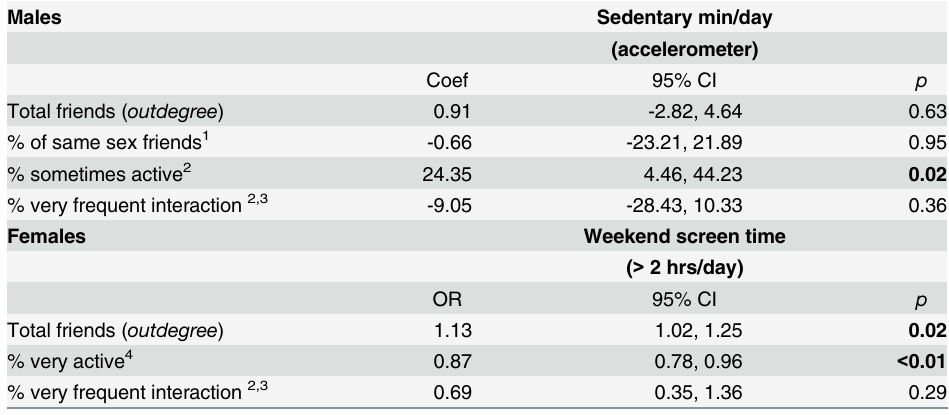
Table 4. Regression models for personal network characteristic predictors of sedentary (males) and weekend-screen time (females). Males Sedentary min/day (accelerometer) Coef 95% CI p Total friends ( outdegree ) 0.91 -2.82, 4.64 0.63 % of same sex friends 1 -0.66 -23.21, 21.89 0.95 % sometimes active 2 24.35 4.46, 44.23 0.02 % very frequent interaction 2,3 -9.05 -28.43, 10.33 0.36 Females Weekend screen time ( > 2 hrs/day) OR 95% CI p Total friends ( outdegree ) 1.13 1.02, 1.25 0.02 % very active 4 0.87 0.78, 0.96 < 0.01 % very frequent interaction 2,3 0.69 0.35, 1.36 0.29 All models controlled for individual level (age and weight status) and school level covariates. Objective measured sedentary time models controlled for accelerometer wear time. OR, odds ratio; 95% CI, 95% con fi dence interval p, test value, boldface indicates statistical signi fi cance (p < 0.05) 1 . Binary variable recoded as either 100% or less than 100%; 2 . Binary variable coded as either 0% or greater than 0%; 3 . Frequency of interaction at least 3 of 4 from recess, lunch, after school or weekends; 4 . 10-point scale